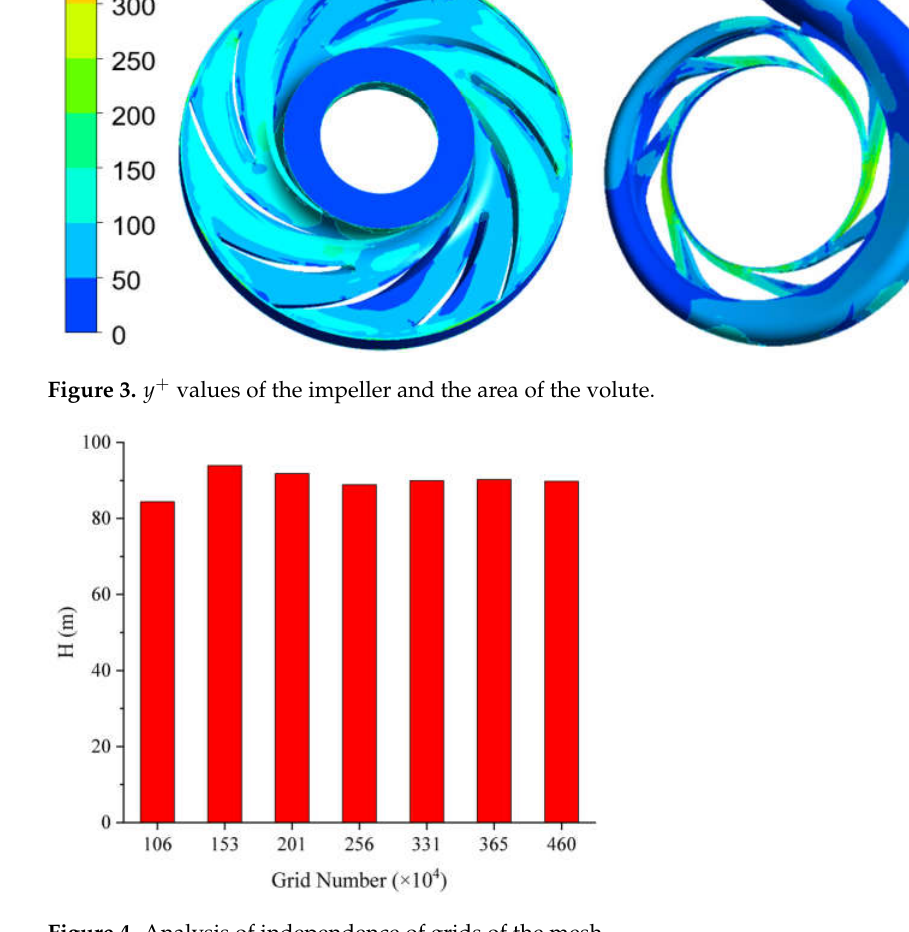
Figure 5. Surface mesh of the impeller: ( a ) leading edge and ( b ) trailing edge. Figure 6. Time-step independence analysis.